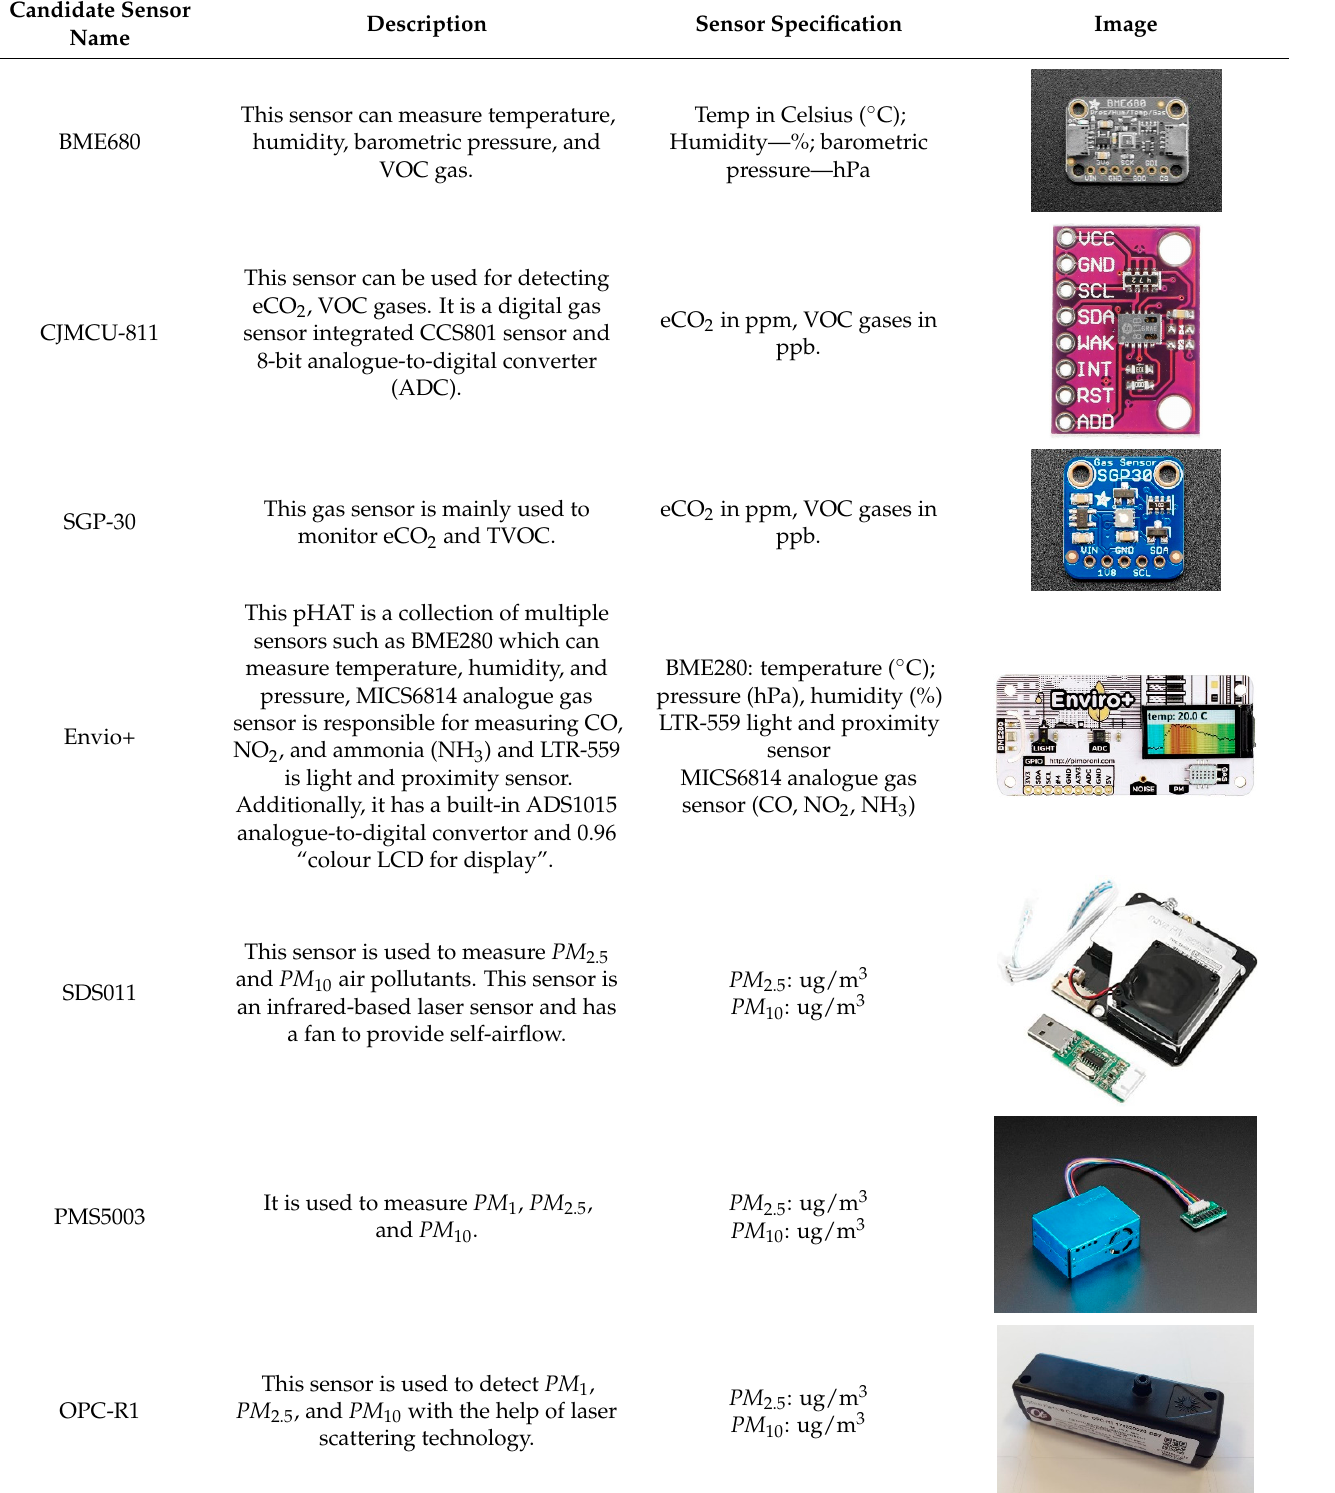
Table 1. List of candidate sensors and their details.